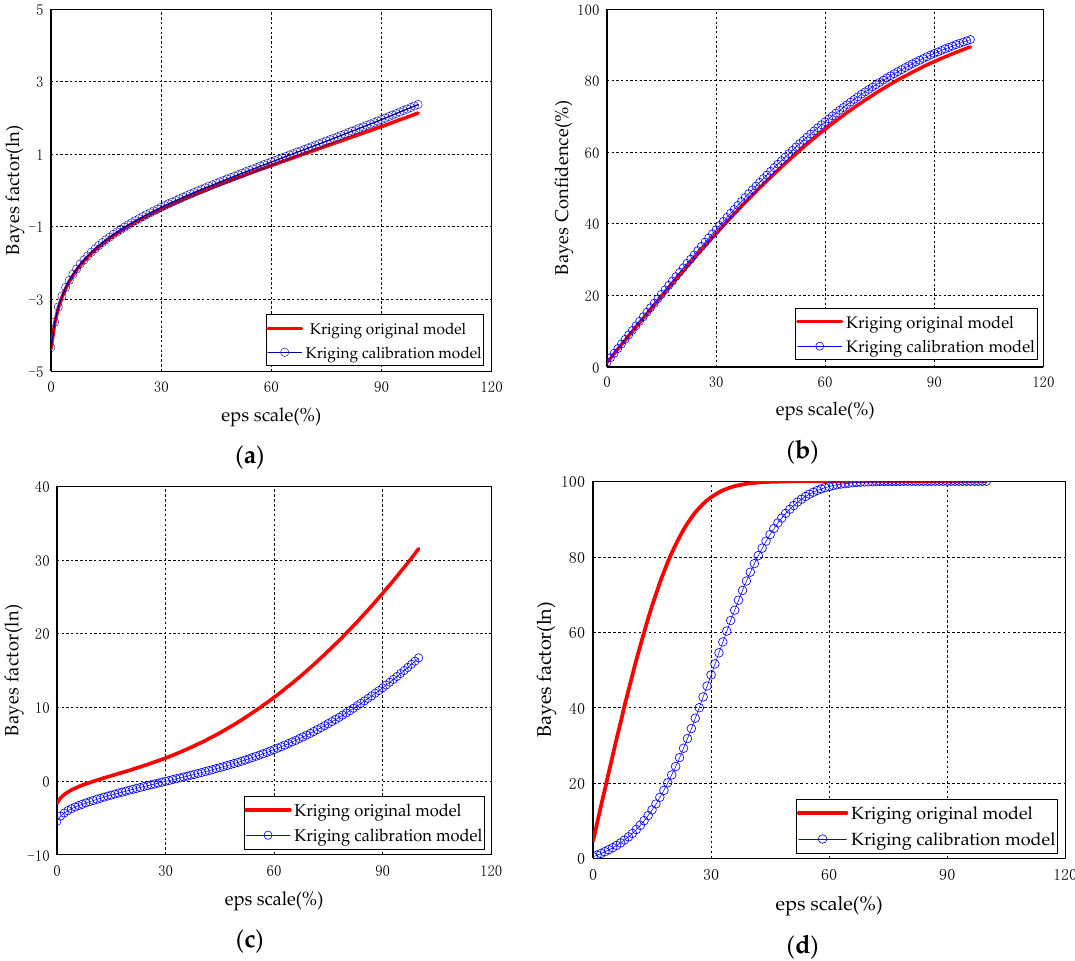
Figure 6. Bayesian hypothesis testing for the kriging and calibrated models: ( a ) Bayes factor of the original data; ( b ) Bayes confidence of the original data; ( c ) Bayes factor of the transformed data; ( d ) Bayes confidence of the transformed data.